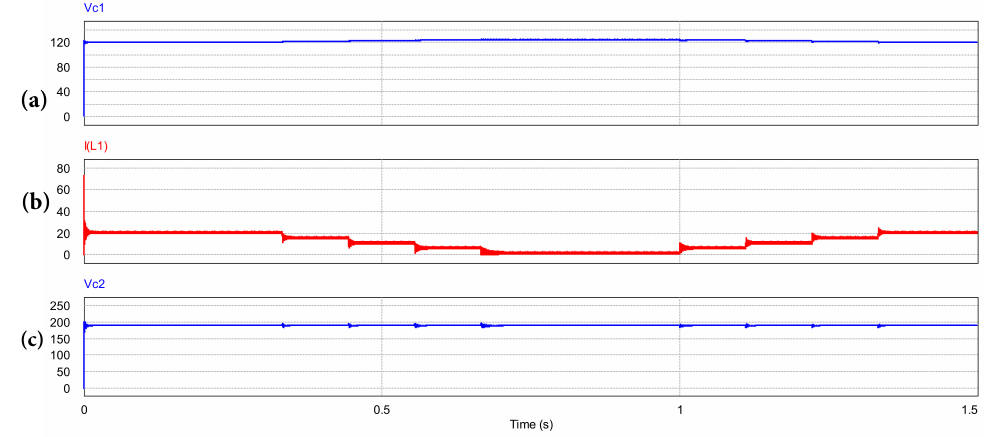
Figure 15. Boost converter 2.5 kW at 190 V with state feedback controller. ( a ) input voltage, ( b ) inductor current and ( c ) output voltage.